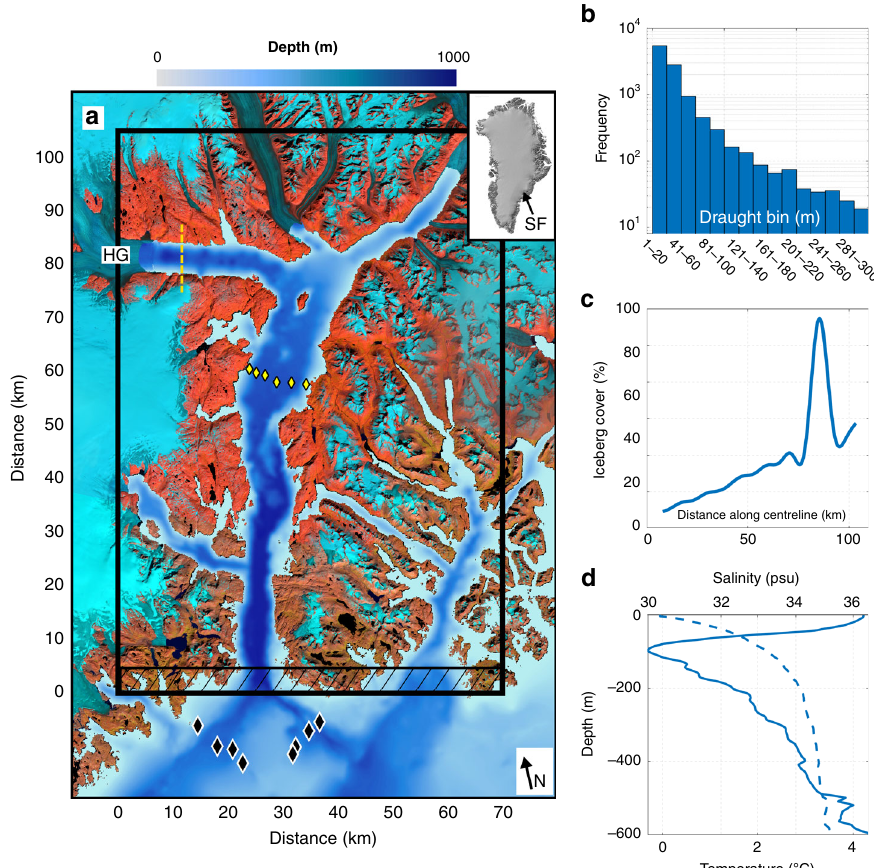
Fig. 1 Study area and model domain. a BedMachine v3 39 bathymetry of Sermilik Fjord, with the inset showing its location in Greenland. The inset was created using the Greenland Ice Mapping Project digital elevation model 78 . The background image is a mosaic of fi ve Landsat 8 false-colour composites (bands 6, 5 and 4) acquired on 12 July, 21, 23, 28 and 15 August 2017. HG = Helheim Glacier. b Iceberg draught-frequency distribution used in the primary simulations, based on observations by Sulak et al. 40 . c The percent of the fjord surface in plan-view covered by icebergs. d Temperature (solid line) and salinity (dashed line) boundary conditions. The black box in a denotes the limit of the model domain. The black hatching in a denotes the relaxation zone (Methods). The black diamonds in a indicate locations of conductivity-temperature-depth casts used for boundary conditions ( d ) and the yellow diamonds are conductivity-temperature-depth casts used in Fig. 7. The yellow dashed line in a is the fl ux gate used in our heat fl ux calculations